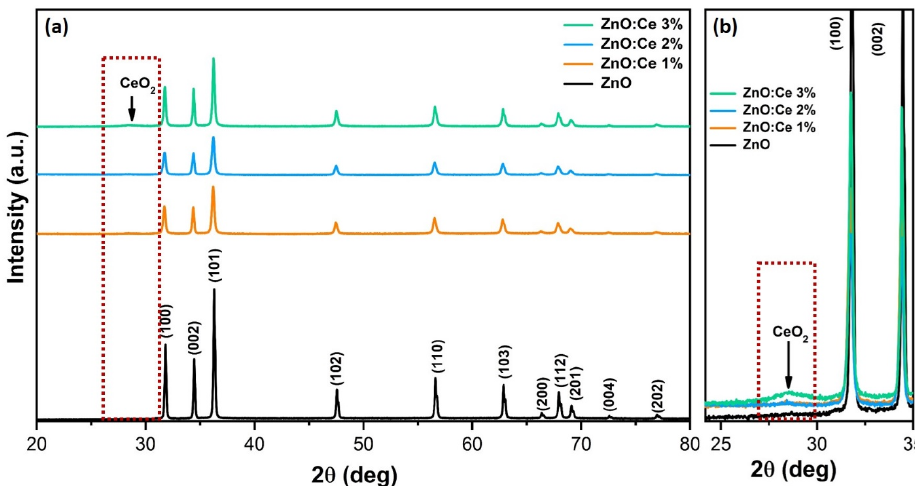
Figure 1. ( a ) XRD patterns of the ZnO and Ce / ZnO photocatalysts at di ff erent Ce concentrations. ( b ) Zoom on the region in the XRD illustrating the presence of the (111) peak of the cubic fluorite CeO 2 structure.